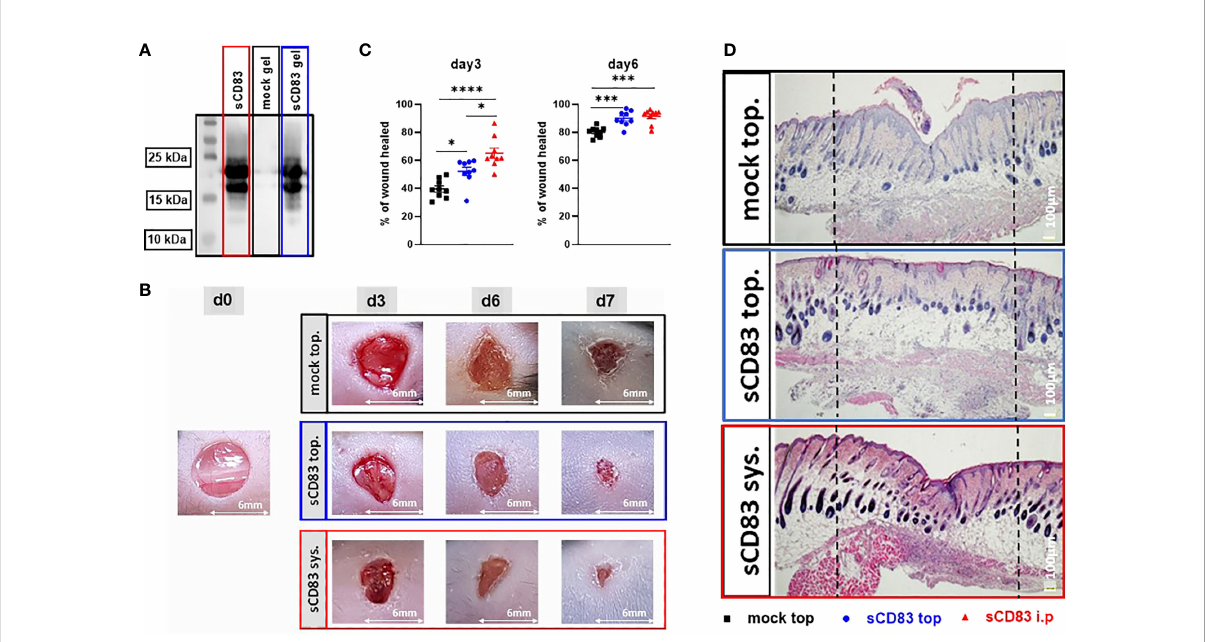
FIGURE 5 Topical sCD83 application induces local wound healing. Wound lesions were induced using 6 mm punches, and diameters were measured by caliper, at indicated time points. (A) Western blot analyses of sCD83-hydrogel matrices after 10 days at 4°C, demonstrate the stability of the sCD83 protein. (B) Daily topical administration of sCD83 on days 1, 3 and 5 signi fi cantly increased wound healing. (C) Percentage of wound closure was set relatively to the day 0 value, with each group n=10. (D) Representative histological analyses of day 7 samples. Dashed lines mark the former wound sites. Data are illustrated as mean ± SEM and statistically analysed using One-way ANOVA for C. Asterisks mark statistically signi fi cant difference (*p < 0.05, ***p < 0.001 and ****p < 0.0001). The absence of asterisks indicates that there is no statistical signi fi